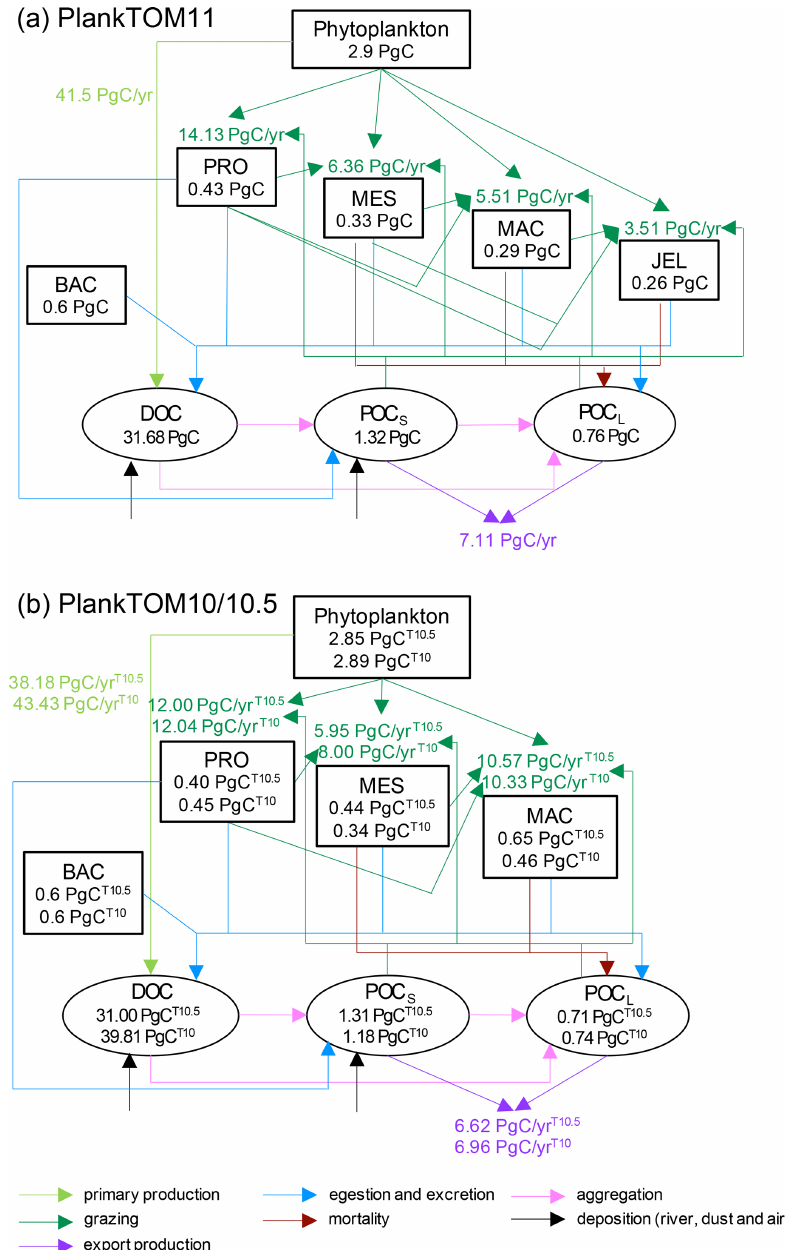
Figure A2. Schematic representation of global carbon biomass and rates in the PlankTOM marine ecosystem model including sources and sinks for dissolved organic carbon (DOC) and small (POC S ) and large (POC L ) particulate organic carbon. (a) PlankTOM11 and (b) Plank- TOM10 or PlankTOM10.5. Carbon biomass (PgC) of PFTs and organic carbon pools are given within boxes and ovals respectively. Carbon rates (PgCyr − 1 ) of primary production (light green), grazing (dark green) and export production (purple) are given next to the corresponding arrows. All data are averaged for 1985 to